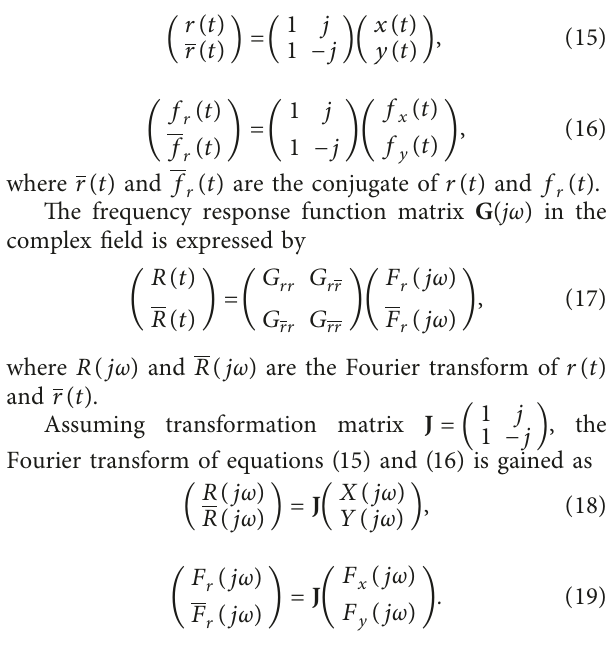
Figure 10: Dynamic characteristic coefficients as a function of rotating speed. (a) Stiffness coefficients. (b) Damping